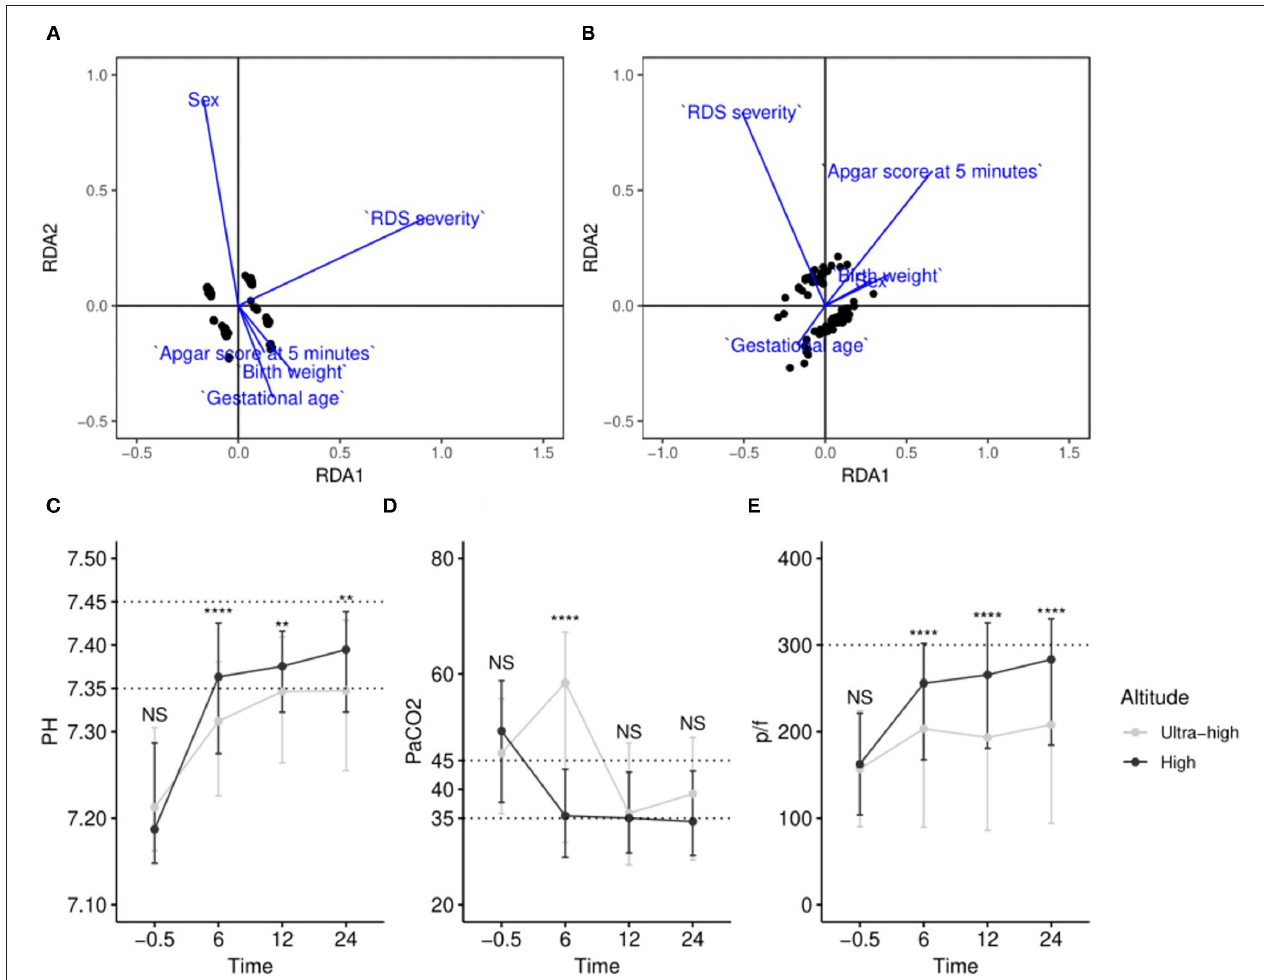
FIGURE 5 | Comprehensive evaluation by redundancy analysis and comparison of blood gas targets at various time points in different altitudes. (A) RDA model of samples in high altitude; (B) RDA model of samples in ultra-high altitude; (C–E) changes of pH, PaCO 2 , and p/f at various time points at different altitudes. NS P > 0.05; **0.001 < P < 0.01; **** P <